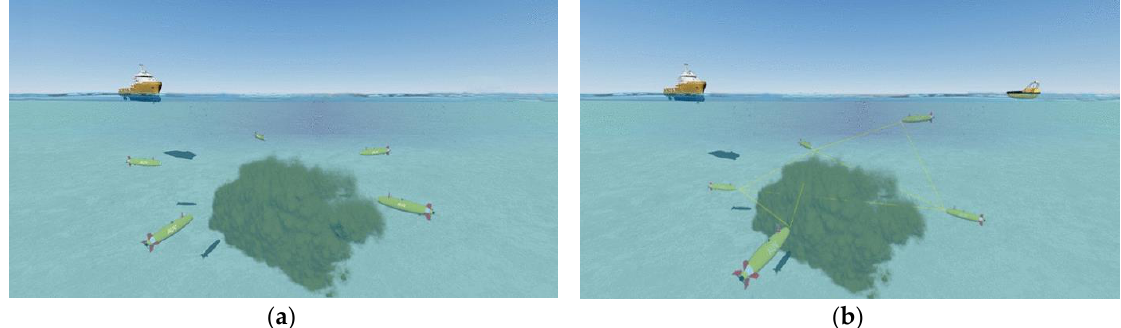
Figure 2. Use case of detection, inspection and traction of plumes in the SWARMs project: ( a ) AUVs tracking and detecting the plume; ( b ) AUVs sharing the information between each other.